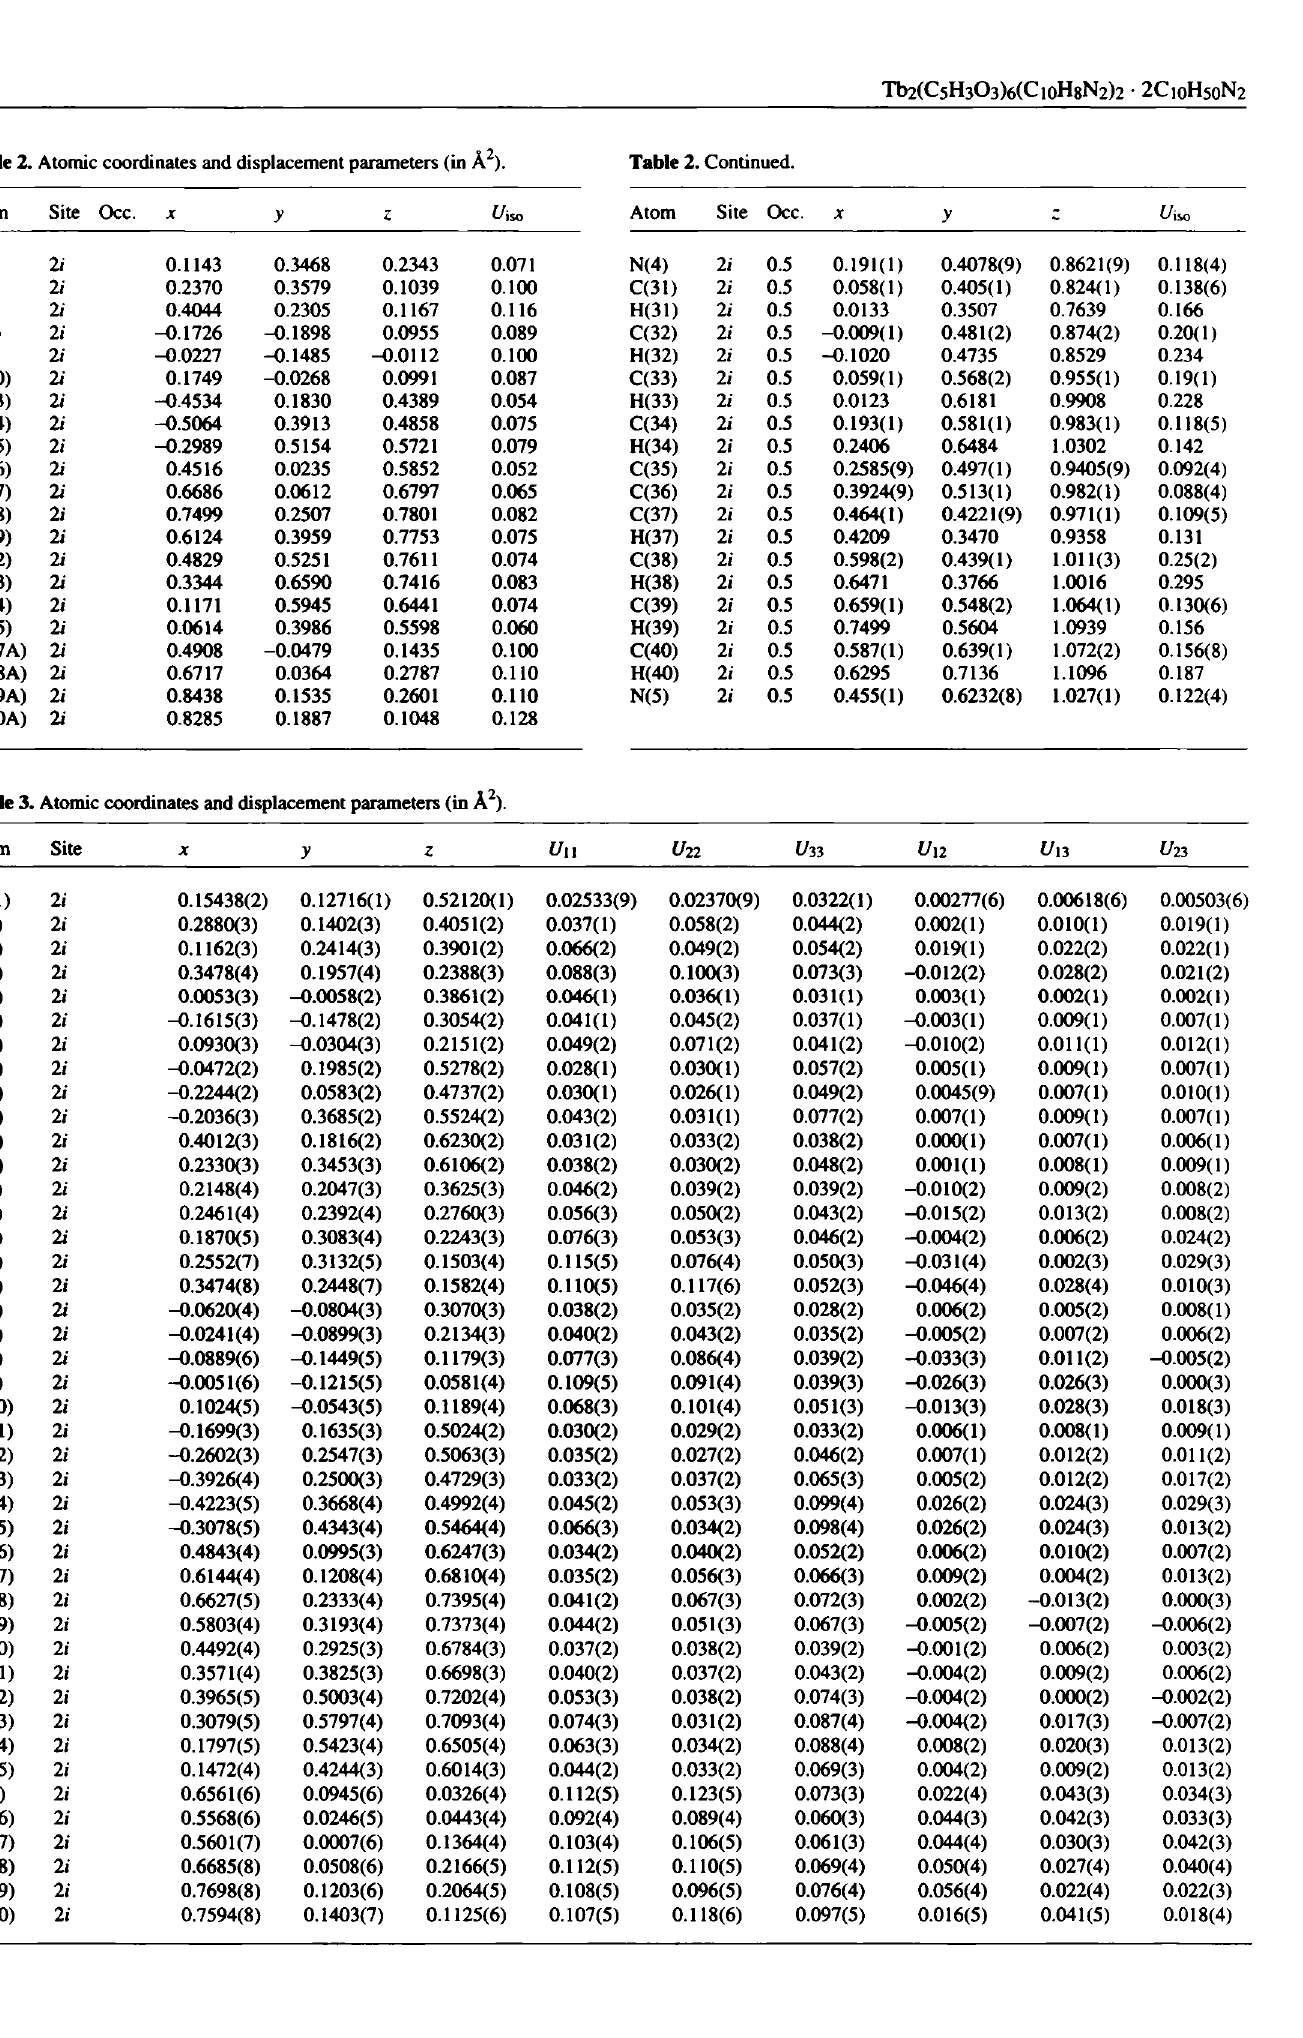
Table 3. Atomic coordinates and displacement parameters (in A 2